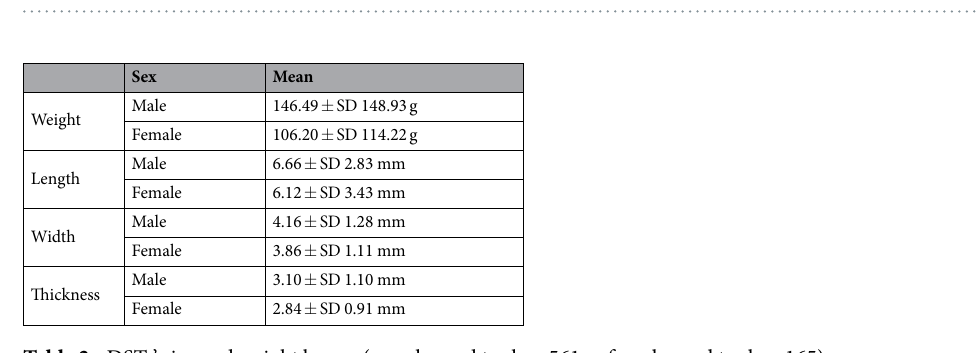
Table 2. DSTs’ size and weight by sex (n male used tools = 561; n female used tools = 165).